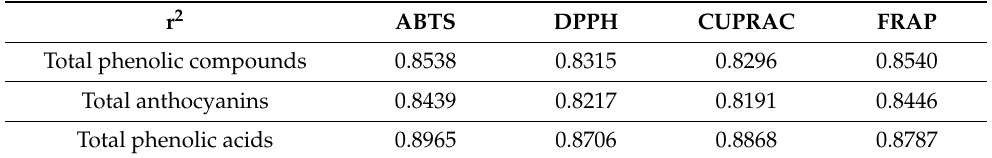
Table 7. Calculated correlation coefficients of the dependence of antioxidant activity determined using ABTS, DPPH, CUPRAC, and FRAP assays and the sum of total phenolic compounds, total anthocyanins, and total phenolic acids determined by HPLC-DAD. r